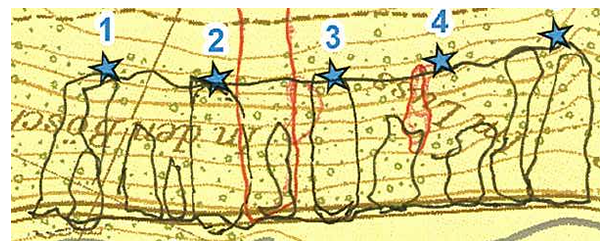
Figure 13. Observed avalanches on 2 February 2014, as mapped from local avalanche service (black boundaries). Stars represent ar- eas where avalanche control is normally performed. The red bound- aries delineate avalanches that were artificially released the day af- ter the natural avalanches occurred.